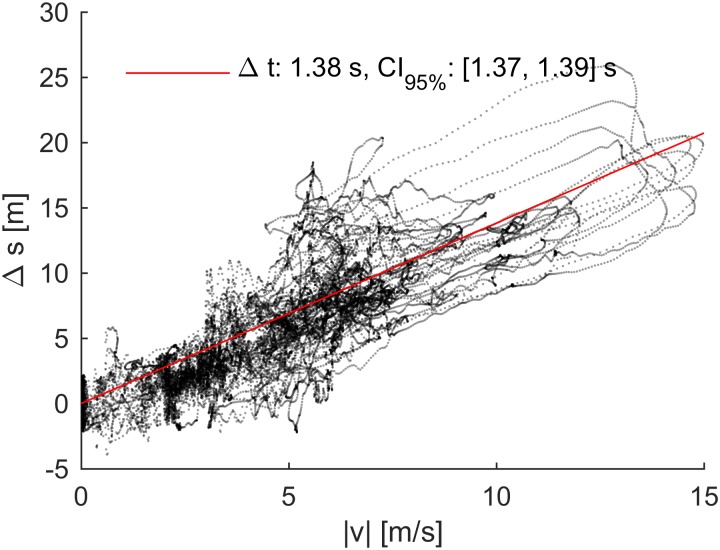
Example of the synchronization procedure used for the Gar-920XT and Cat-S5 receivers. If the receivers are not time synchronized with the reference receiver, it results in a position deviation in the direction of travel (Δs) that increases linearly with skiing speed (|v|). The slope of the fitted line is an estimate of the synchronization offset.